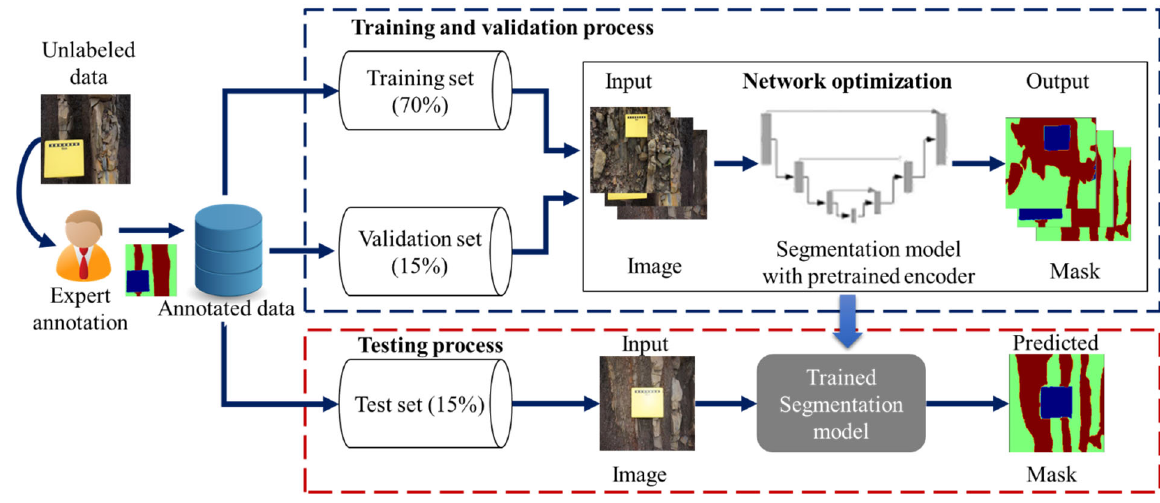
Figure 2. Experimental framework.